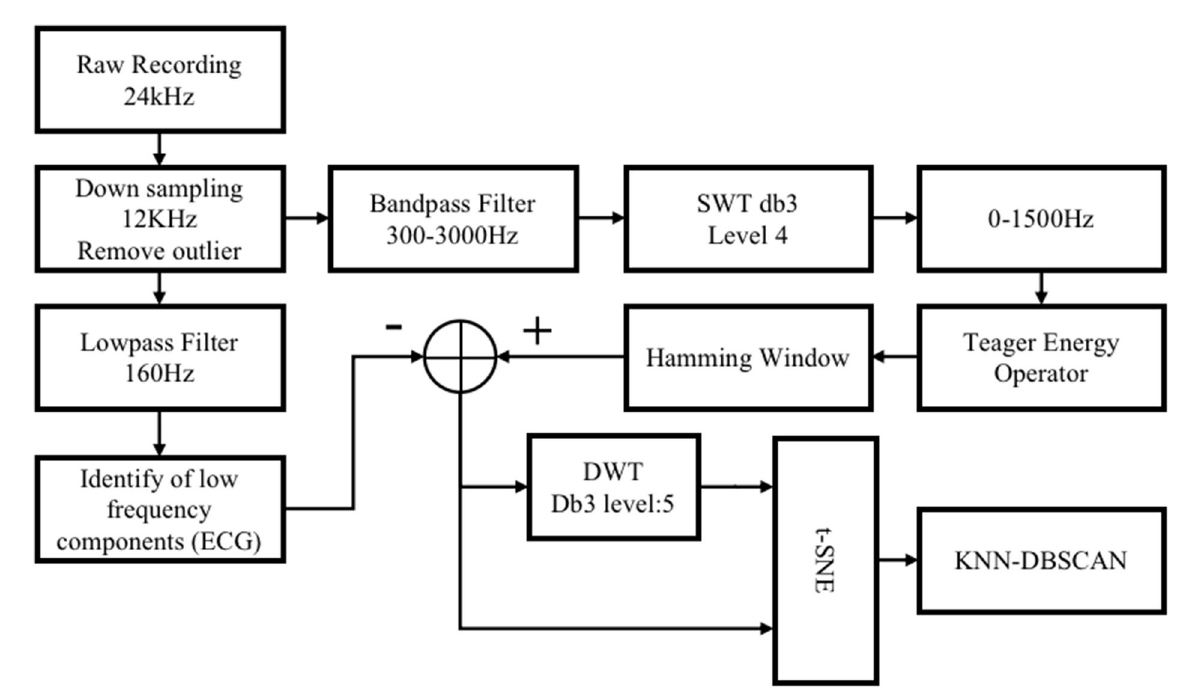
FIGURE2 Schematic diagram of the compound neural action potential (CNAP) detection and the clustering algorithm.